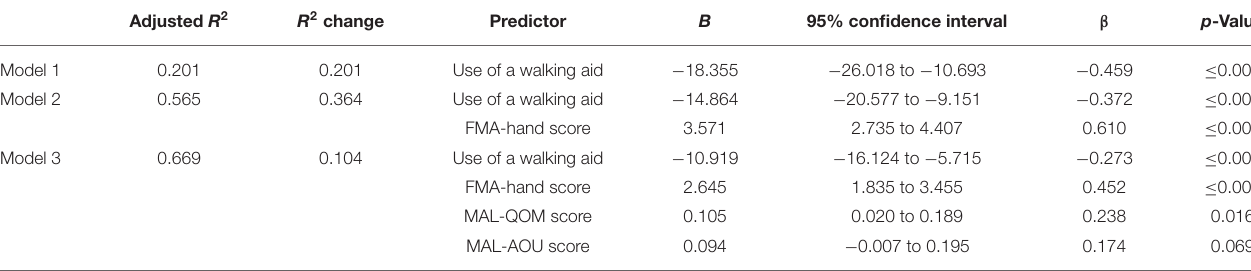
TABLE 4 | Relationships between ARAT scores and other variables. Adjusted R 2 R 2 change Predictor